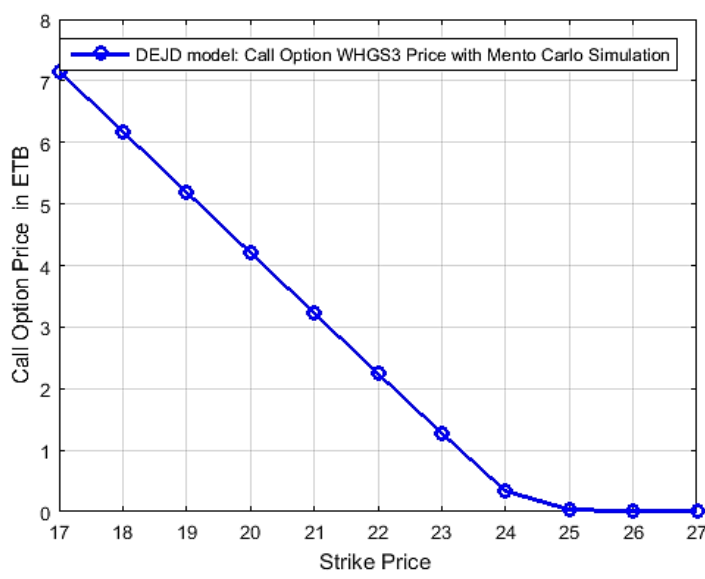
Figure 11. Call option WHGS3 price under DEJD